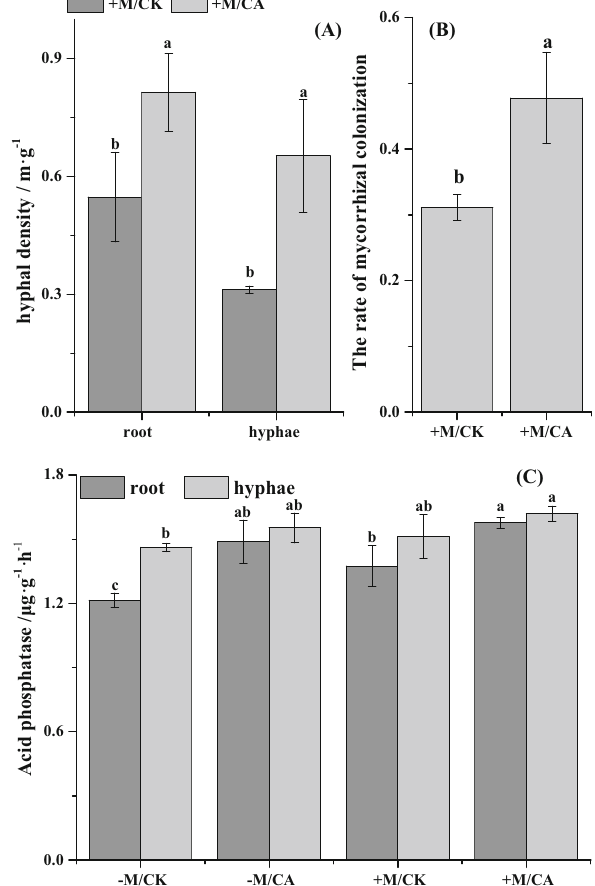
Fig. 2 Hyphae density ( a ), the rate of mycorrhizal colonization ( b ) and soil acid phosphatase ( c ) under different treatments. Note : different lowercase letters refer to significant difference among treatments in the same compartment ( p \